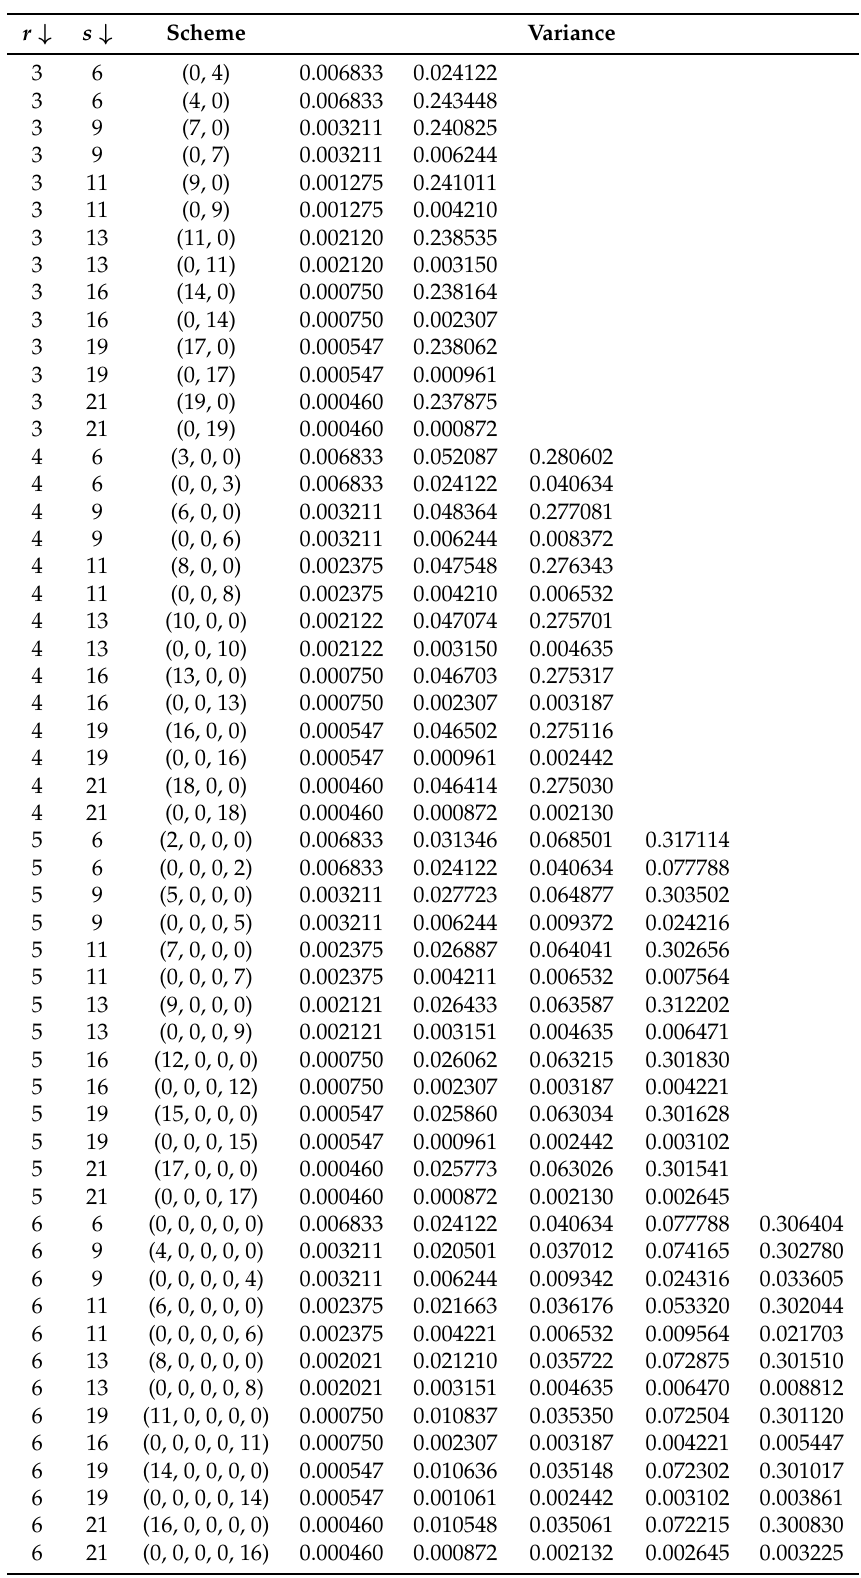
Table 3. Variances of two parameter RK distribution for different values of parameters, e.g., µ = 2 and λ =